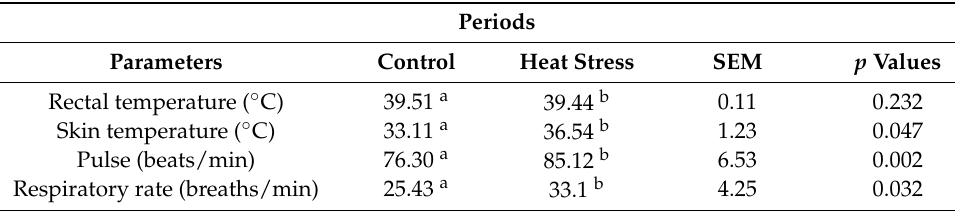
Table 3. The skin temperature, rectal temperature, respiratory rate, and pulse of the goats between control and heat stress periods.